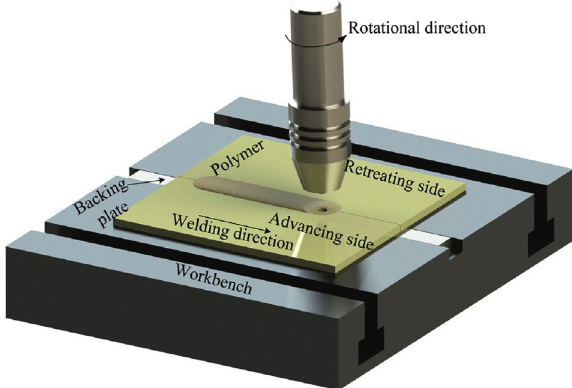
Figure 1: Schematic diagram of